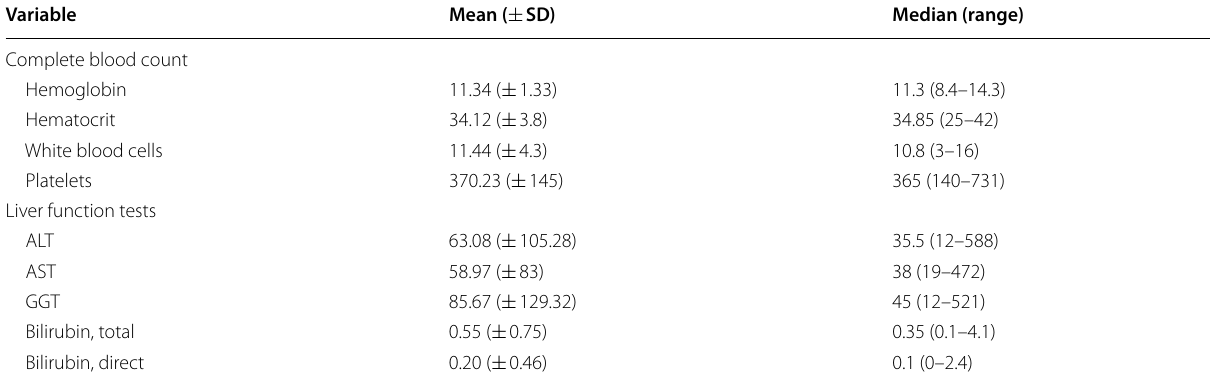
Table 3 Laboratory parameters of the studied patients Variable